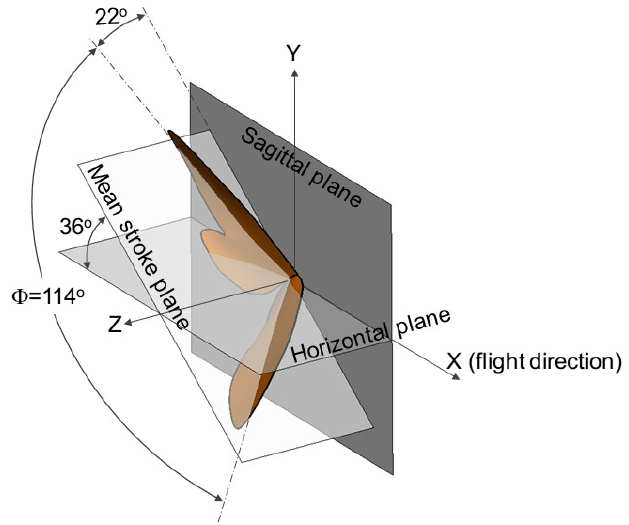
Figure 1. Wing kinematics depicted with wing positions at the start of the each half-stroke. Φ = stroke  = stroke amplitude.